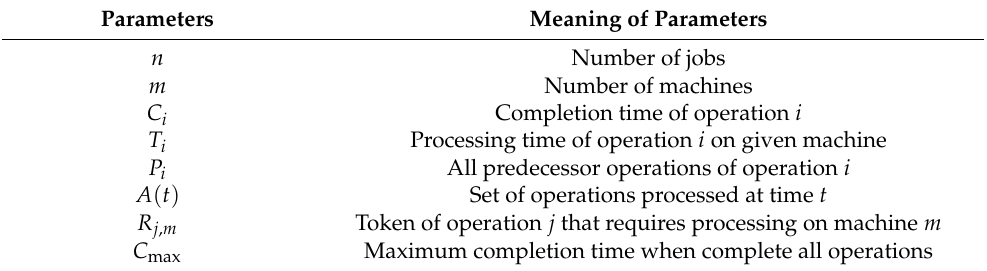
Table 2. Detailed description of parameters